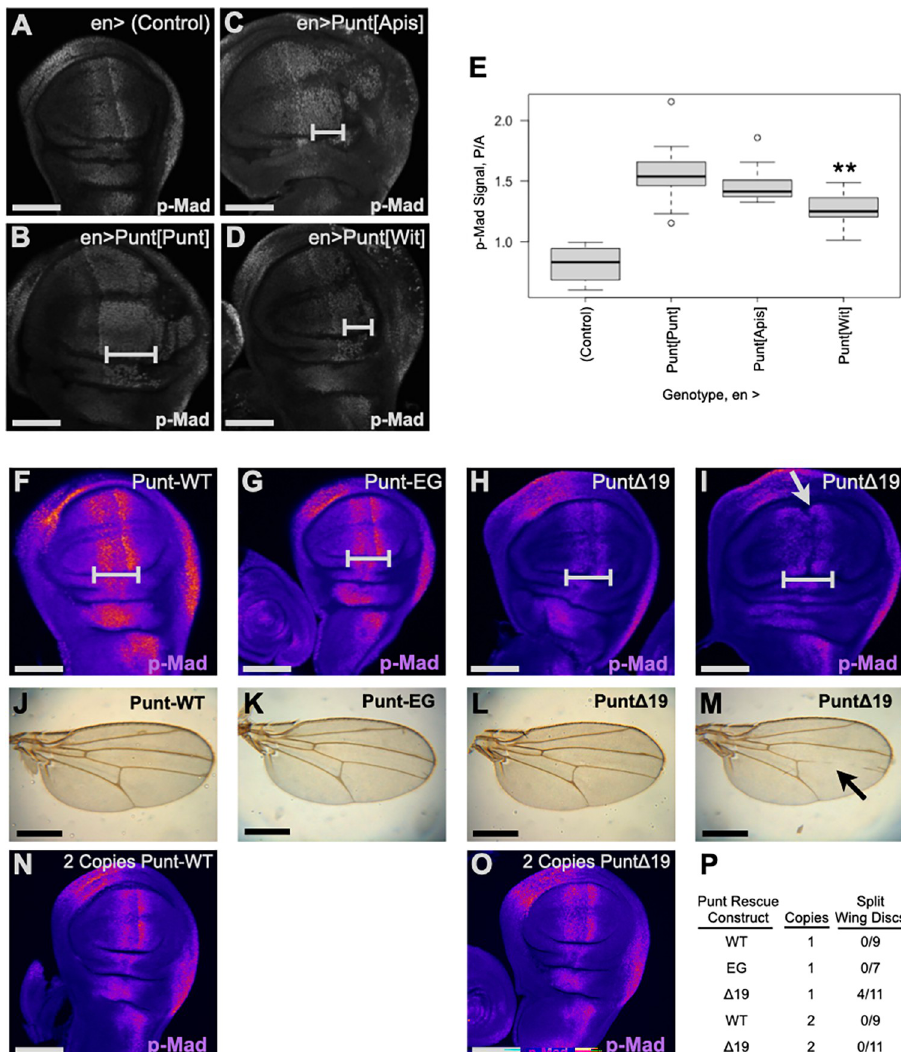
Fig 6. The BLT motif positively supports Dpp signaling. (A–E) Ectopic activity of overexpressed Punt was diminished upon apicalization. p-Mad pattern in the wing disc for control (A) and en > Punt[BLT] proteins (B–D). Ectopic p-Mad staining is marked by brackets (B–D). The ratio of p-Mad signal from the posterior compartment ( en- positive) versus anterior compartment increased for each Punt[BLT] protein, but less so for Punt[Wit] ( �� p < 0.01 Punt[Wit] versus Punt[Punt]) (E). (F–M) Apicalized Punt did not fully support Dpp signaling or wing development at a dosage of one copy. Representative wing disc p-Mad staining from put mutant larvae rescued by the indicated construct (F–I), shown as false color Fire scale of MIPs. Note reduced p-Mad intensity in the pouch region above the bracket in panels H-I. Δ 19 animals showed a variable morphology, with 4 of 11 discs having an abnormal furrow along the A/P boundary (gray arrow in panel I). (J–M) Wings from adults from rescued genotypes. Δ 19 wings (L, M) showed variability in vein patterns (arrow in M). (N, P) Signaling and tissue patterning is dose dependent. Two copies of the Δ 19 rescue construct boosted Dpp signaling to normal levels (N, O). One-copy images (F–I) are from one staining batch and 2-copy images (N, O) are from a different staining batch. Developmental defects were only observed with the Δ 19 construct at a dosage of one copy (P). Scale bars: 100 μ m A–D, F–I, N, O; 500 μ m for J–M. The data underlying the graph shown in this figure can be found in S1 Data. BLT, basolateral targeting; Dpp,